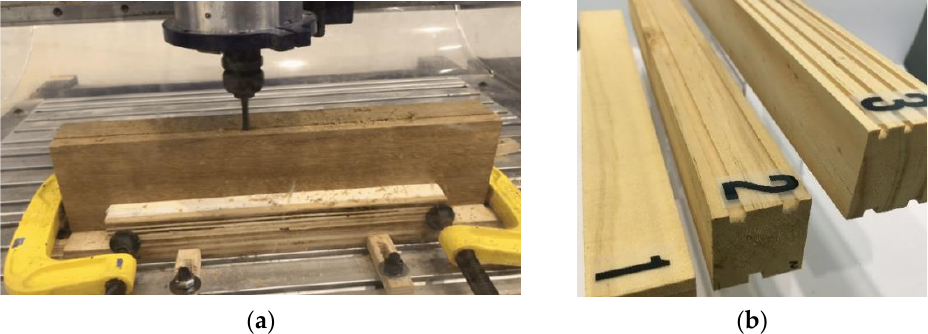
Figure 2. ( a ) A milling machine grooving design patterns for fibers ’ lamination; ( b ) Case 2 and Case 3 samples (bottom side up) after grooving, next to benchmark case 1.